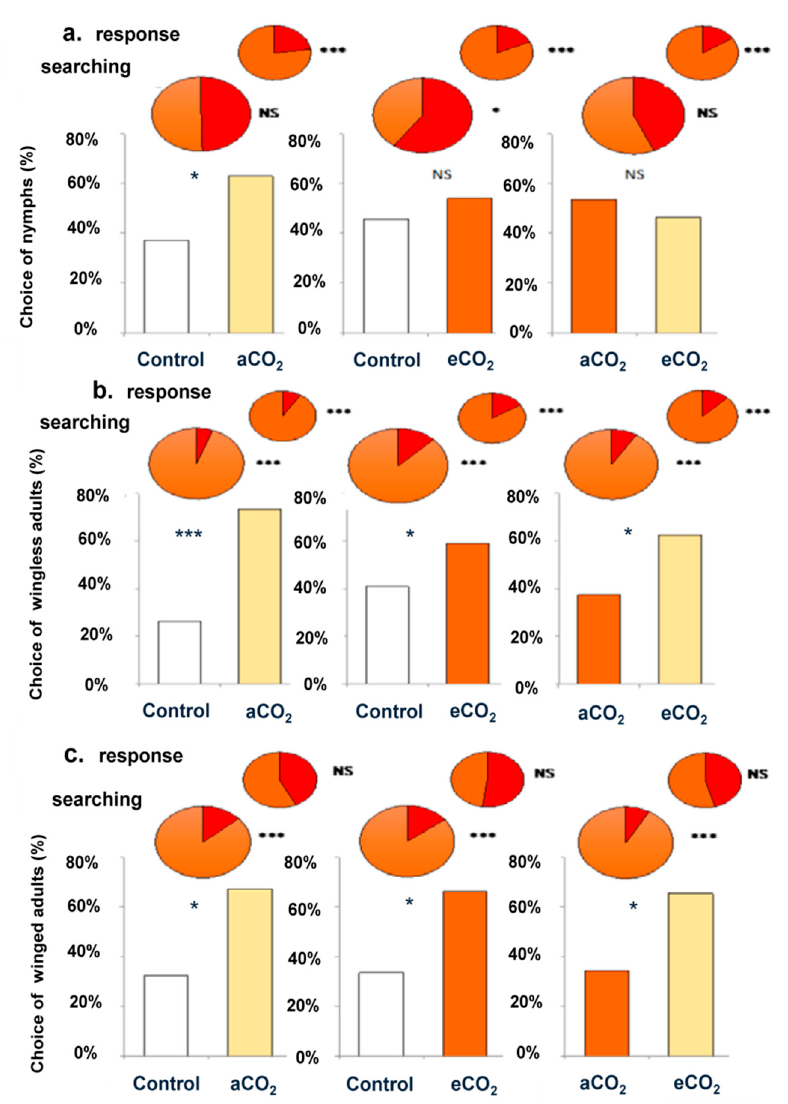
Figure 1. Foraging behavior (in %) of nymph ( a ), wingless ( b ) and winged ( c ) corn leaf aphid during three dual choices including control, aCO 2 and eCO 2 barley seedling combinations. Response and searching status assessment corresponded to mobility in the first 2 cm, and before the split of the olfactometer 2 arms, respectively. Red color in pies was negative behaviors (For example, orange color in pies pointed to response, and red color pointed to no response). There were three replicates for each treatment, and a total of 180 aphids were tested. *, *** and NS for p ≤ 0.05, p ≤ 0.001 and not significant at α = 0.05, respectively.